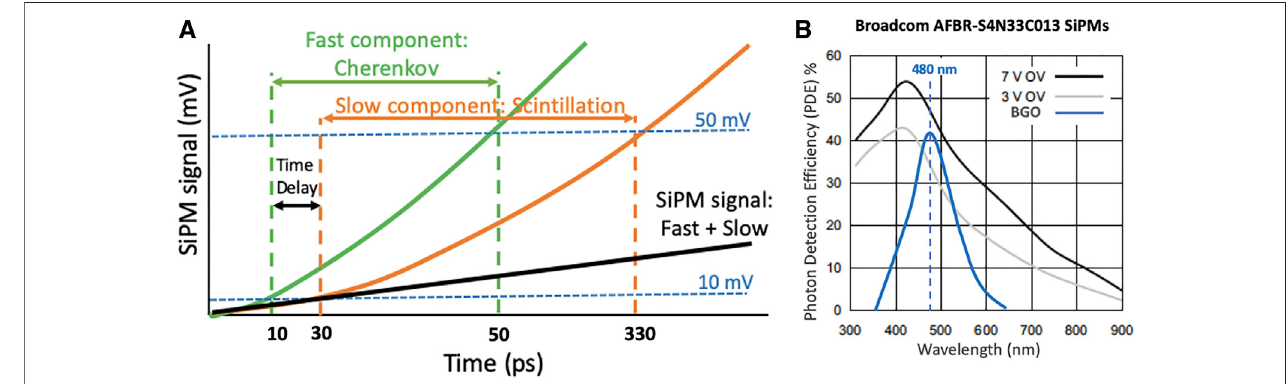
FIGURE 1 | (A) . BGO ’ s temporal components, the green line represents the fast decay component (45 – 60 ns) which corresponds to the emitted Cherenkov photons, and the orange line represents the slow decay component (300 – 365 ns) of the scintillation luminescence (original plot extracted from [20]). (B) .